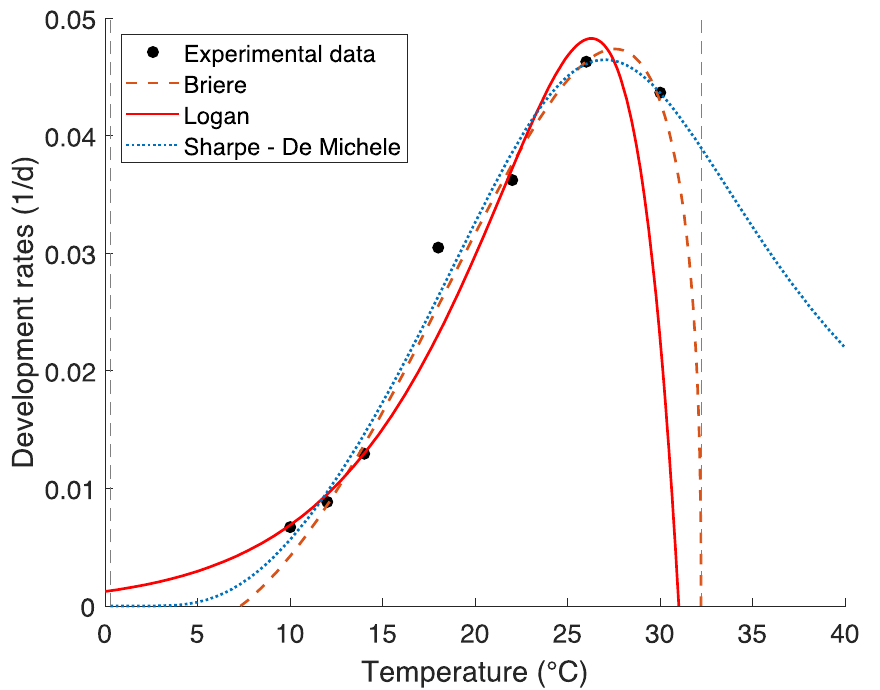
Figure 2. Best fit development rate functions for Bactrocera oleae using the dataset published by Wang et al. [35]. Numerical values and goodness of fit parameters are listed in Table 1.